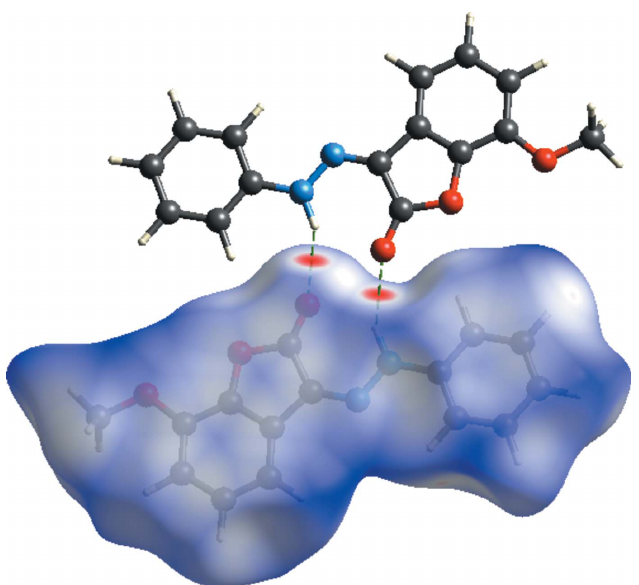
Figure 5 View of the three-dimensional Hirshfeld surface of the title compound plotted over d norm in the range (cid:4) 0.1718 to 1.3843 a.u. The two N—H (cid:2)(cid:2)(cid:2) O hydrogen bonds forming the dimer are depicted as dashed lines.